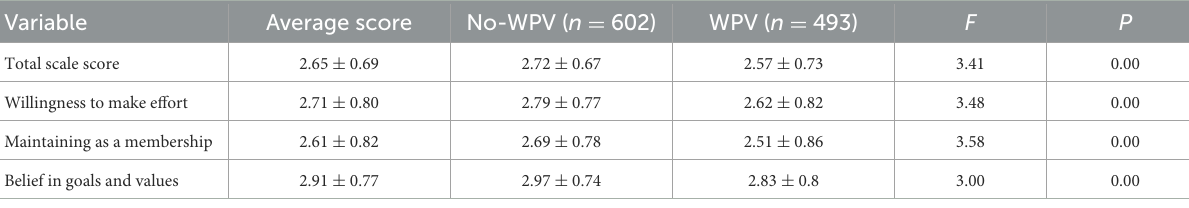
TABLE 4 Professional commitment of nursing interns with and without psychological WPV experience. Variable